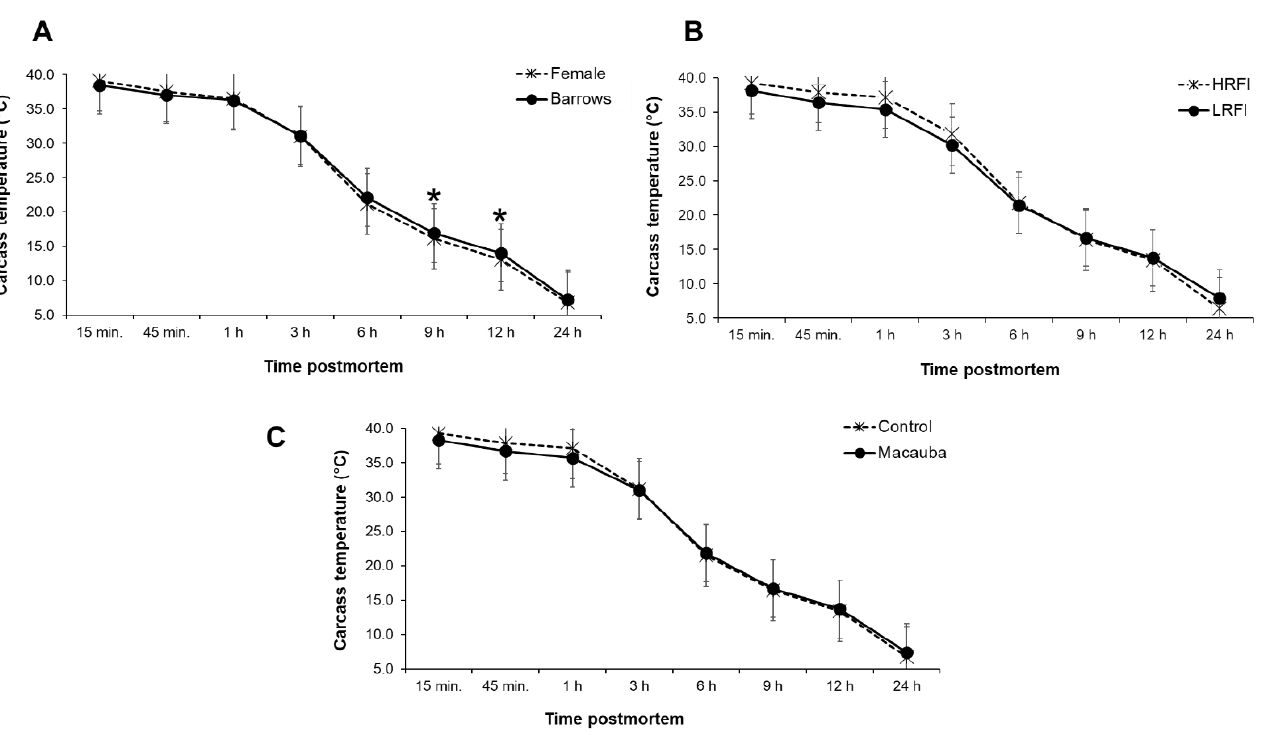
Figure 1. Effect of sex ( A ); sire breeding value ( B ); and diet ( C ) on carcass pH decline during the first 24 h postmortem . Progeny of sires with high (HRFI) or low (LRFI) breeding value for residual feed intake. Each vertical bar is the standard error of the mean. * p < 0.05.